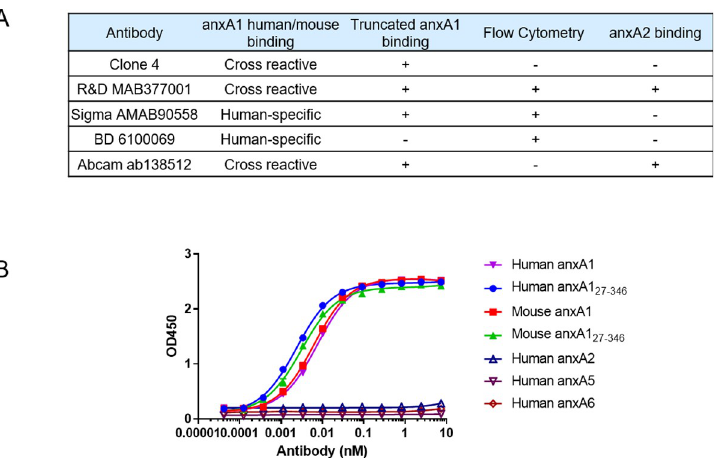
Fig 1. Binding characteristics of commercial anti-anxA1 antibodies. Summary of binding characteristics of commercial antibodies and clone 4-huIgG1 (A), and ELISA binding of clone 4-huIgG1 to full length and N-terminal truncated human and mouse anxA1, with negative binding to human annexin A2, A5, and A6 (B). Interpolated EC50 values: full length human anxA1 7.53 pM, full length mouse anxA1 6.19 pM, human anxA1 27-346 2.36 pM, mouse anxA1 27-346 3.09 pM based on One Site—Total Binding, least squares fit.